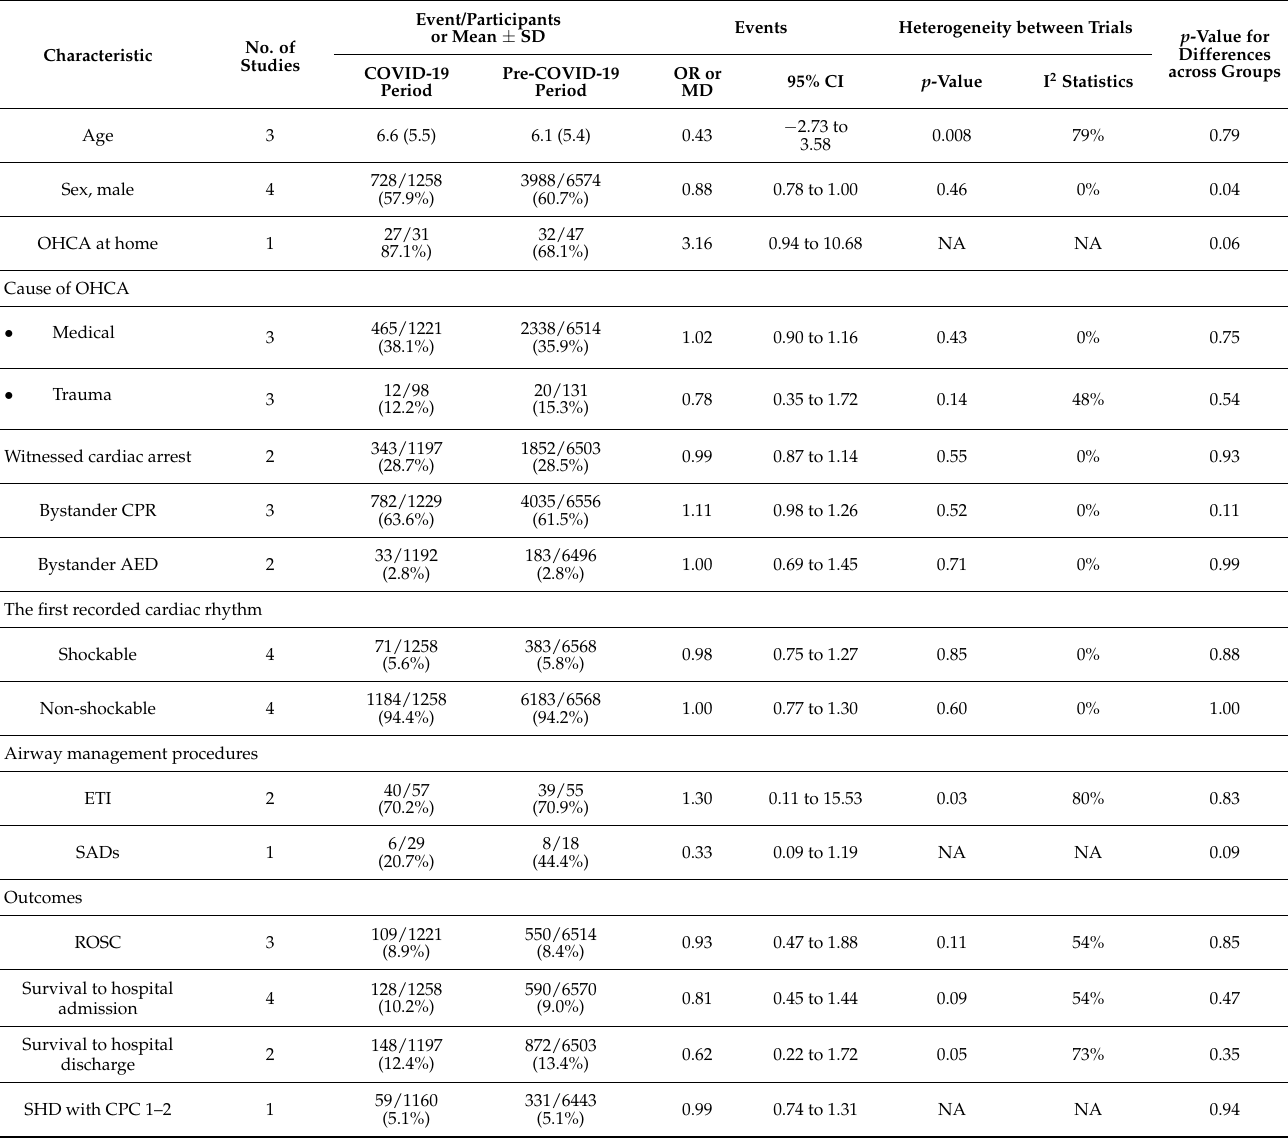
Table 2. Pooled analysis of cardiac arrest